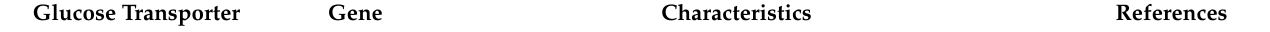
Table 2. Characteristics of sodium-dependent glucose transporters (SGLT proteins) in the healthy human kidneys. Glucose Transporter Gene